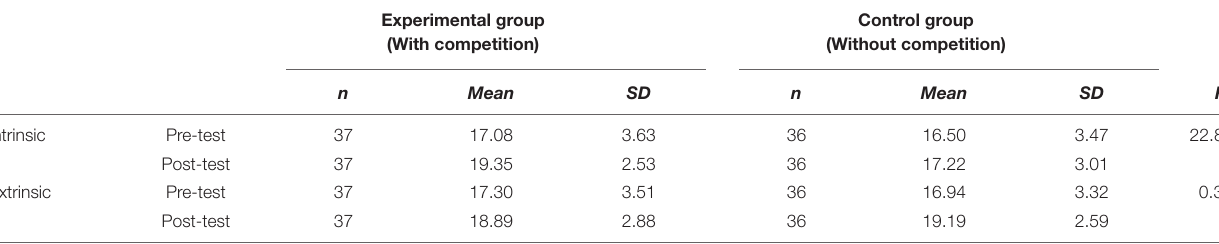
TABLE 2 | Pre- and post-test descriptive statistics for intrinsic/extrinsic motivation.